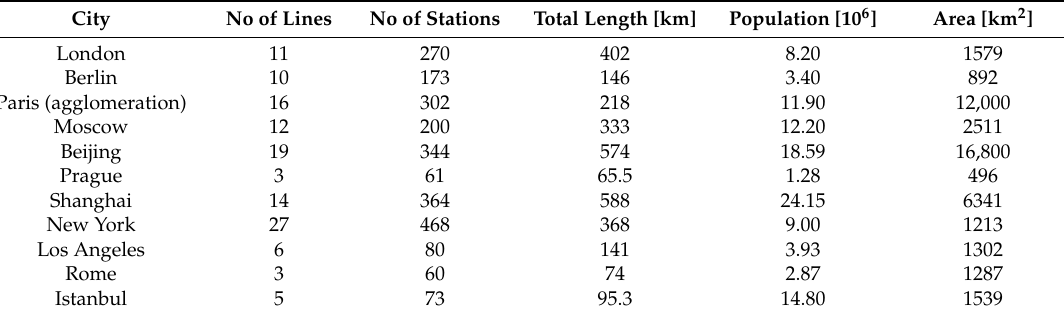
Table 2. Selected metro networks in the world.